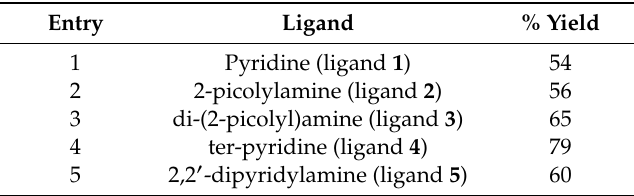
Table 2. Screening of various ligands for the C-P bond formation reaction a